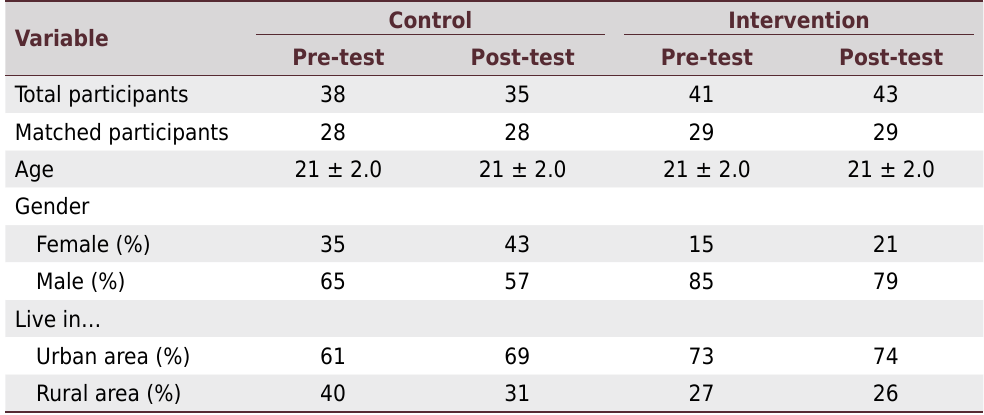
Table 1. Socio-demographic characteristics of participants